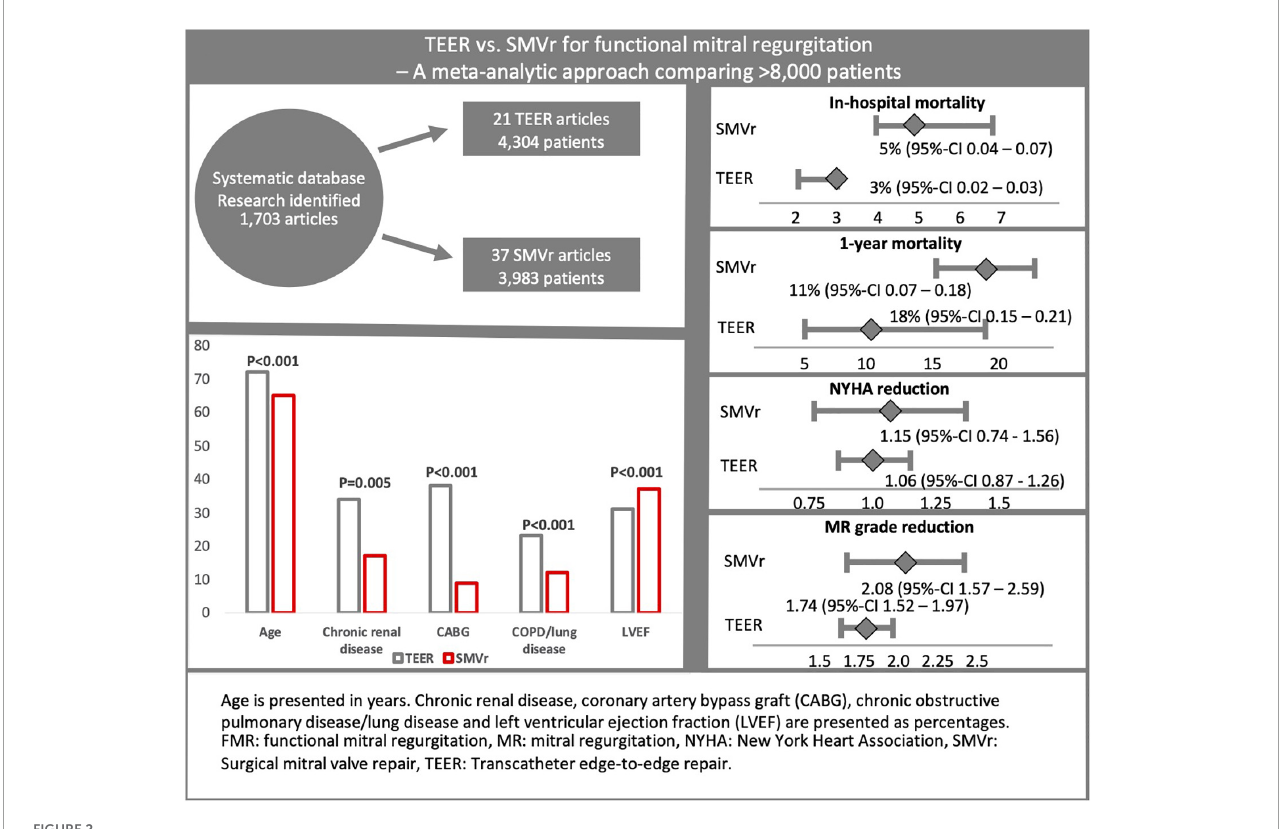
FIGURE2 This graphical abstract summarizes study design, the most important baseline characteristics as well as key results of this meta-analytic approach comparing TEER and SMVr in FMR patients. Following systematic database search, 21 TEER and 37 SMVr studies comprising > 8,000 patients were included. Despite a considerably higher age and comorbidity burden, in-hospital mortality was significantly lower in the TEER cohort. NYHA and MR reduction were comparable between both treatment